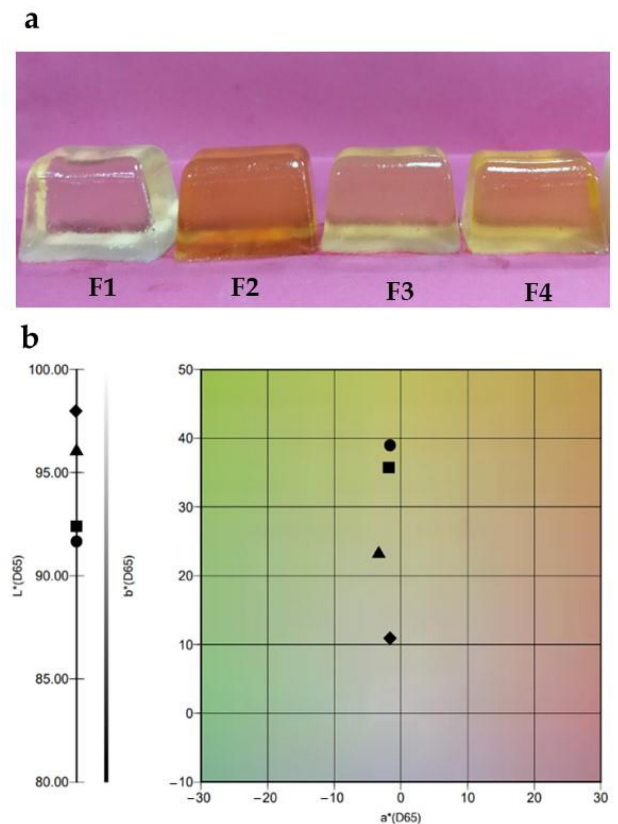
Figure 1. ( a ) The appearance of the gel formulations: F1 (control formulation), F2 (100% agave syrup), F3 (100% agave fructan), and F4 (50% agave syrup and 50% agave fructan); ( b ) CIEL*a*b*spectrum of gels formulation: F1 (rumble), F2 (circle), F3 (triangle), and F4 (square).